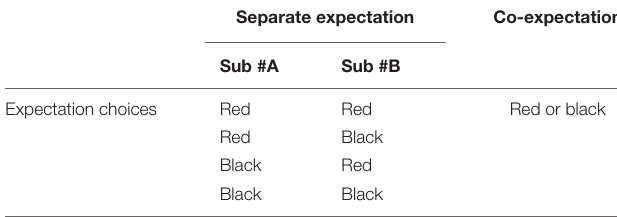
TABLE 2 | Choices by dyads in the two expectation stages.